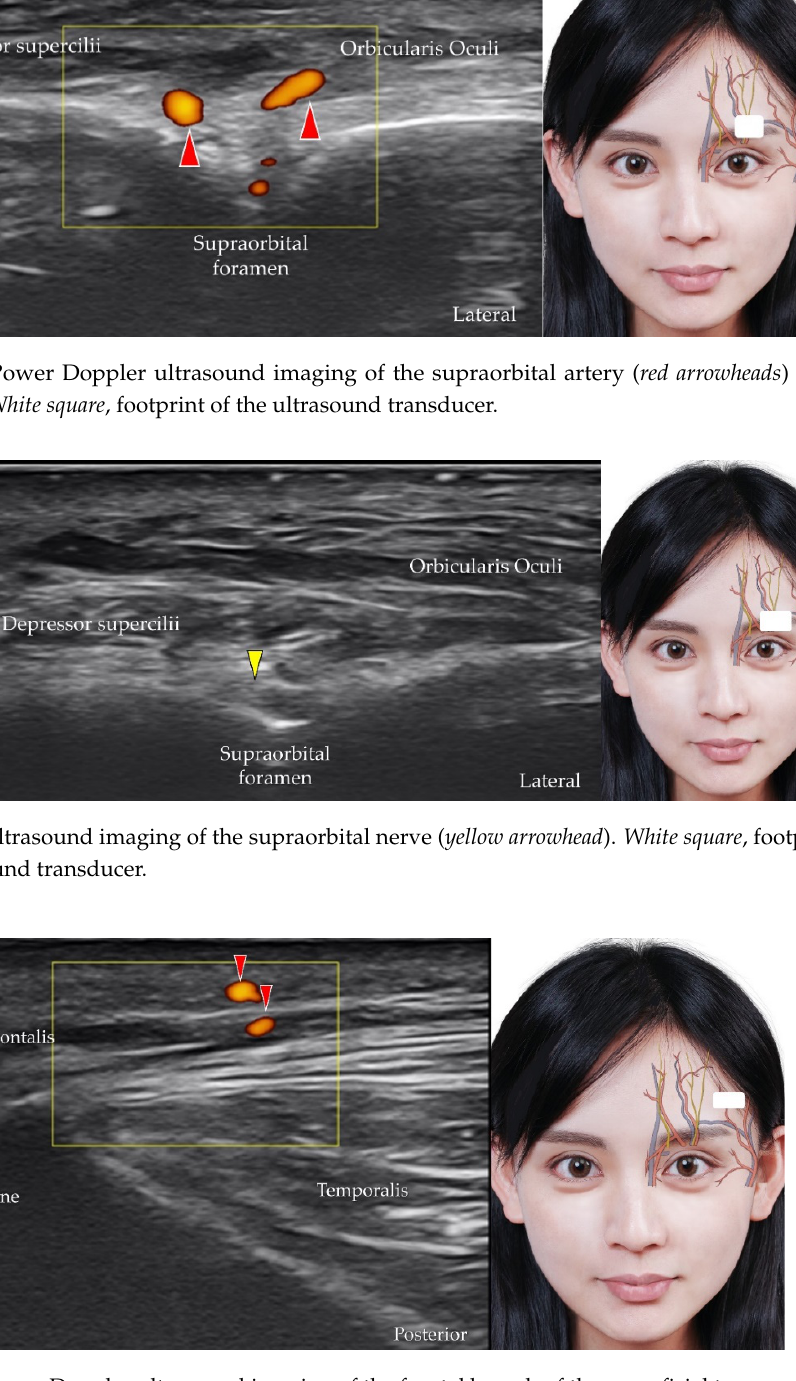
Figure 8. Power Doppler ultrasound imaging of the frontal branch of the superficial temporal artery (red arrowheads) and its branches. White square , footprint of the ultrasound transducer.